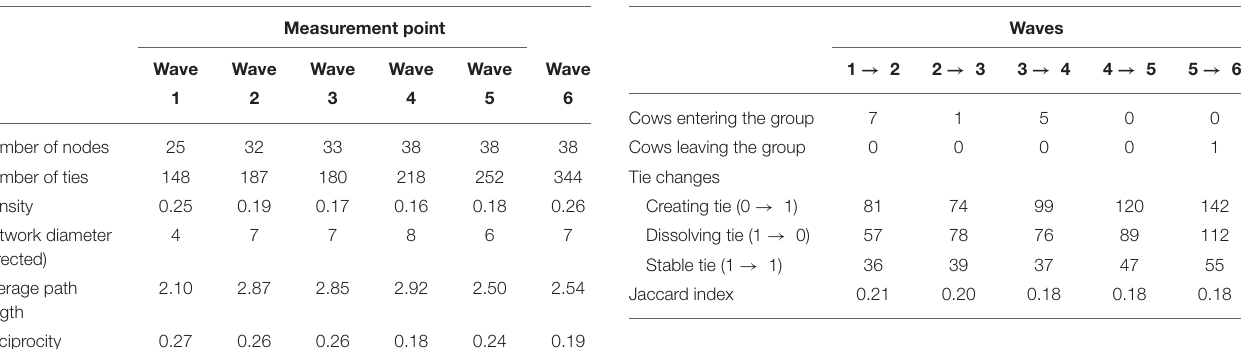
TABLE 3 | Descriptive statistics of network structure. TABLE 4 | Network